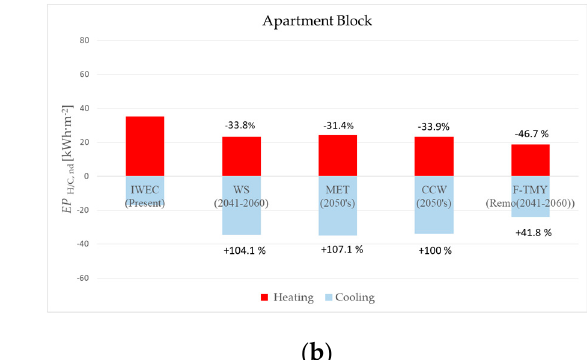
Figure 2. Boxplots of the outdoor dry-bulb temperature ( a ) and the global horizontal solar irradiance during daily hours ( b ) for IWEC (Present), Weathershift (WS), Meteonorm (MET), CCWorldWeatehr-Gen (CCW), and F-TMY. All future weather files are for 2050s considering Representative Concentration Pathway (RCP) 8.5.